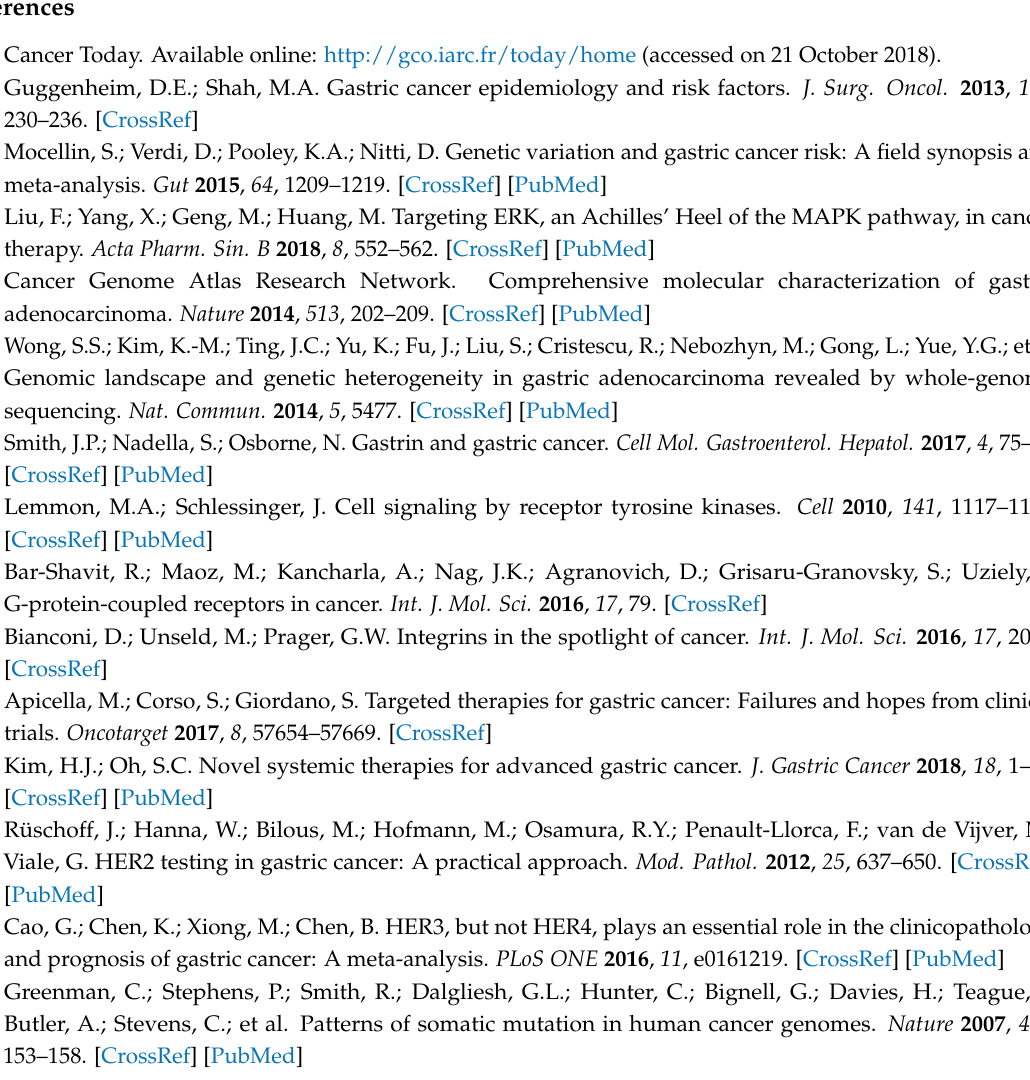
Table S1: Description of the 27 SNPs analyzed in this study, Table S2: Genotype frequencies of studied SNPs among gastric cancer cases and controls, Table S3: Association for the allele model according to clinicopathological features, Table S4: Proxy SNPs of associated variants and their functional